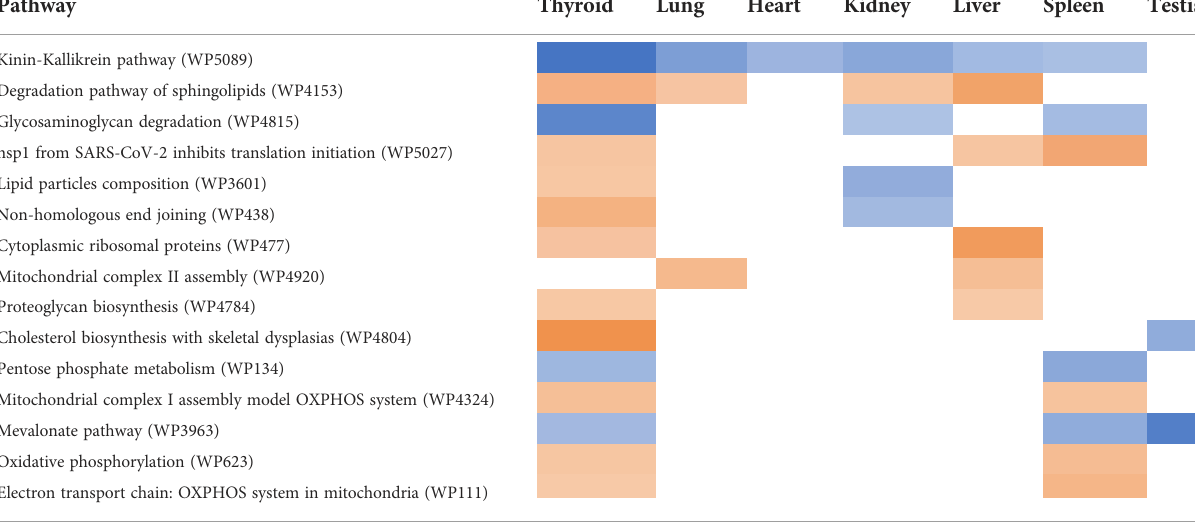
TABLE 1 Pathways with changed protein activity in COVID-19 patients in more than one tissue. Pathway Thyroid Lung Heart Kidney Liver Spleen Testis